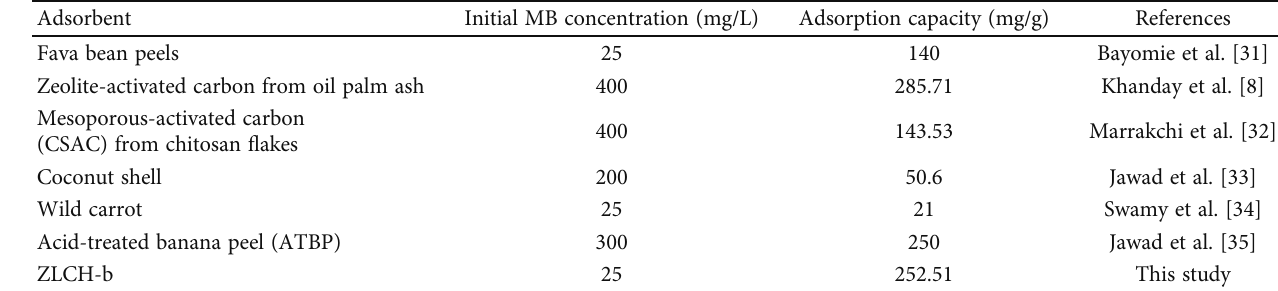
Figure 11: Desorption percentage: (a) di ff erent desorbing agents and (b) di ff erent temperatures using H Table 5: Several adsorbent performances on MB